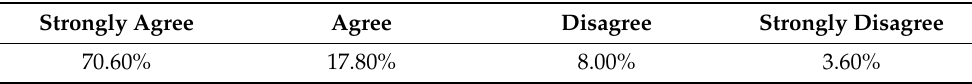
Table 1. Attitudes towards RES or traditional production of electricity. Q: From your point of view, should Romania give up to traditional electricity production (coal, fossil, etc.) and move towards production out of renewable energy sources (aeolian, photovoltaic, biomass)? Strongly Agree Agree Disagree Strongly Disagree 70.60%